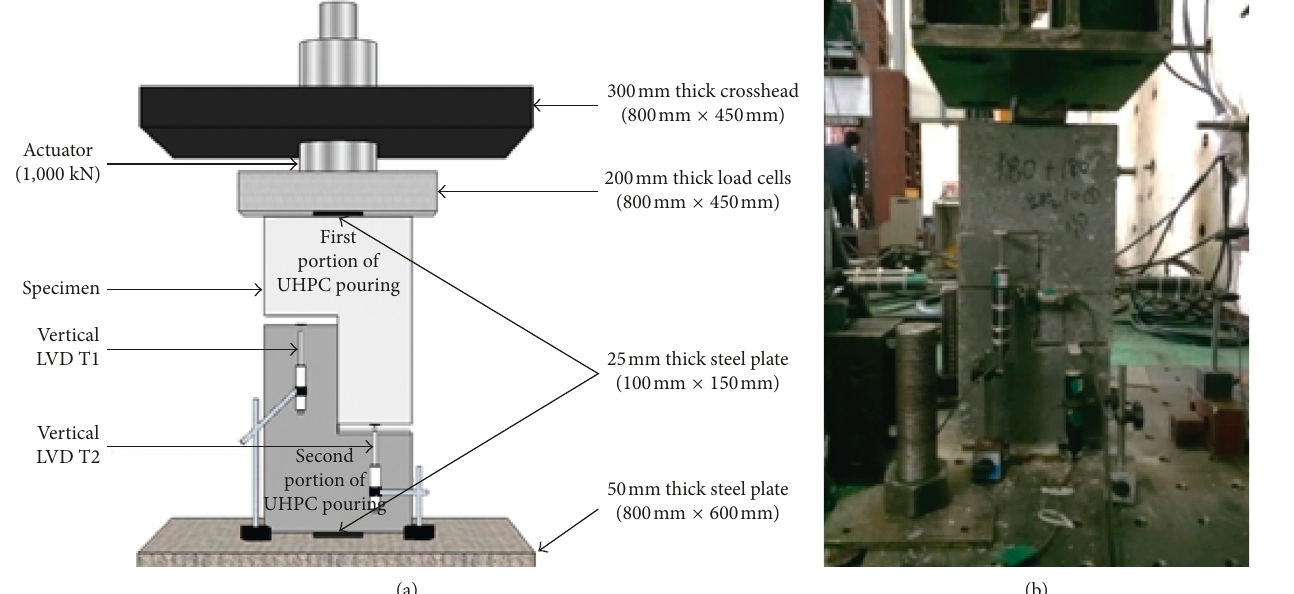
Figure 8: Test setup and instrumentation (reproduced from Jang et al. [29]). (a) Set-up plan; (b) Real experiment.